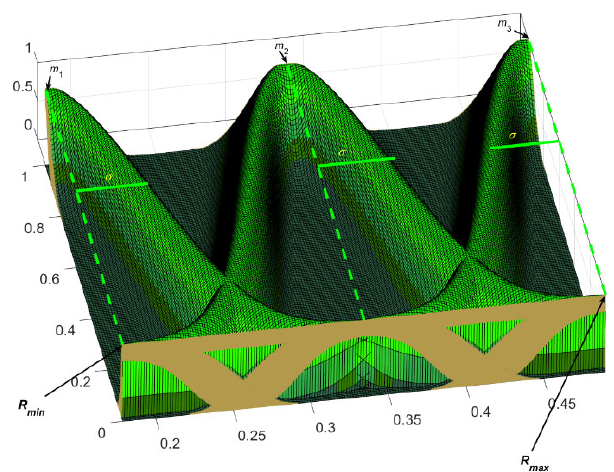
Figure 7. Example of type ‐ 3 fuzzy input variable.